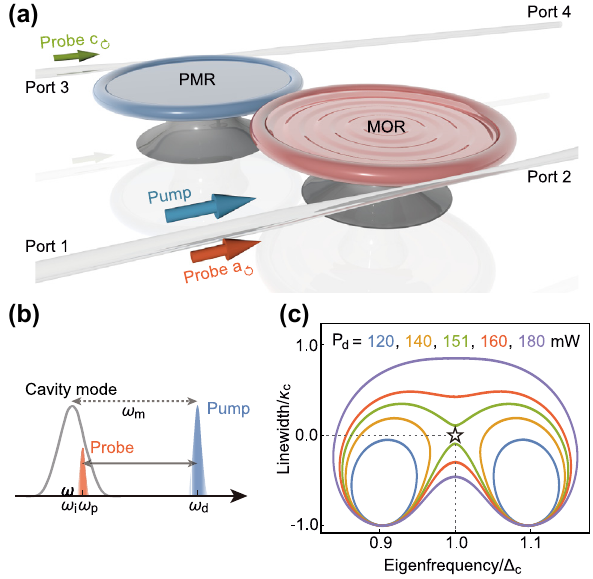
Figure 1: Synthetic  symmetry in a passive optomechanical system without gain materials. (a) Two resonators, denoted by MOR and PMR, are evanescently coupled with each other and also coupled with optical fibers. A blue-detuned pump is input at the port 1 and the probe field enters from the ports 1 and 3. (b) In the pro- pagation direction of the pump, the low-frequency probe acquires an effective gain from the pump via the Stokes process. (c) The eigenfrequency Re [ 𝜔 ] and its linewidth Im [ 𝜔 ] are the functions of the detuning Ω for different values of the pump power P d